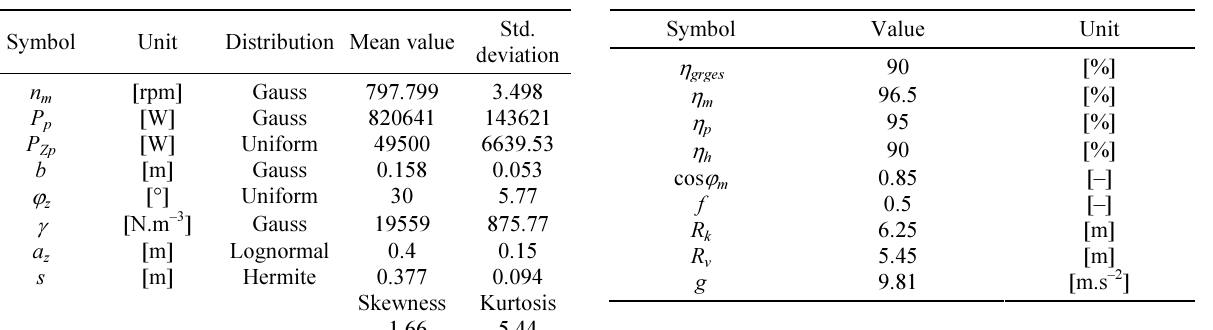
Table 2. Random variables for the first terrace